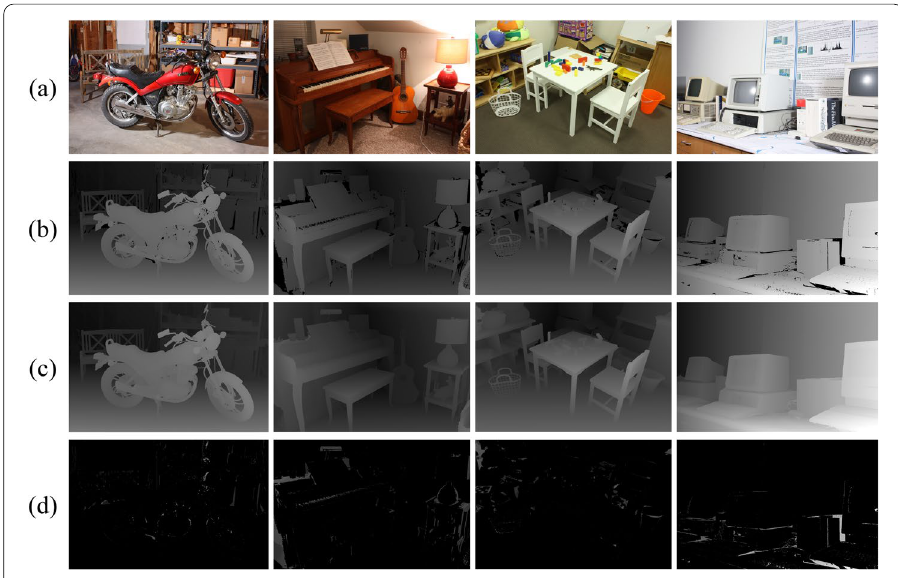
Fig. 11 Visualization results on Middlebury dataset: a original color images, b ground‑truth depth maps with unknown holes, c enhanced depth maps by the proposed IGDE system, d the absolute difference between the original and refinement depth maps